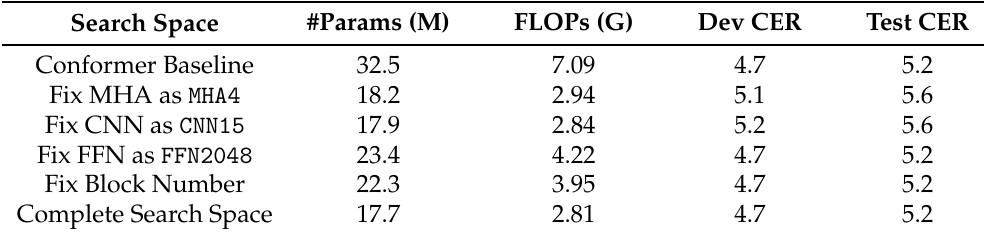
Table 3. Ablation Studies of the search space on Aishell-1. The complete search space is compared with reduced search